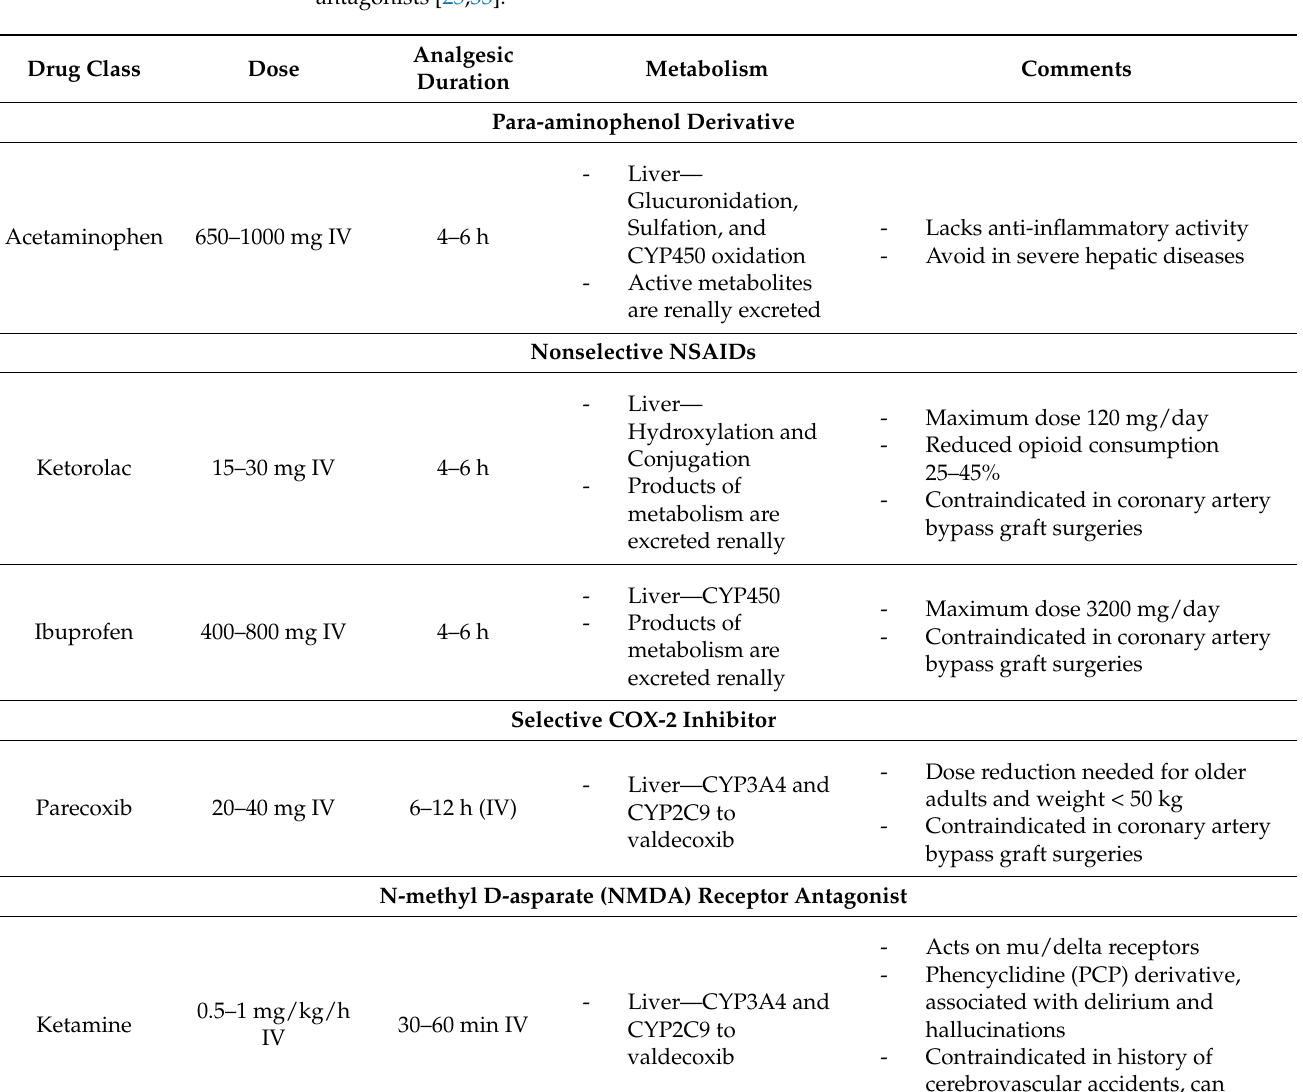
Table 2. Acetaminophen, nonselective and selective NSAIDs, COX-2 inhibitors, and NMDA receptor antagonists